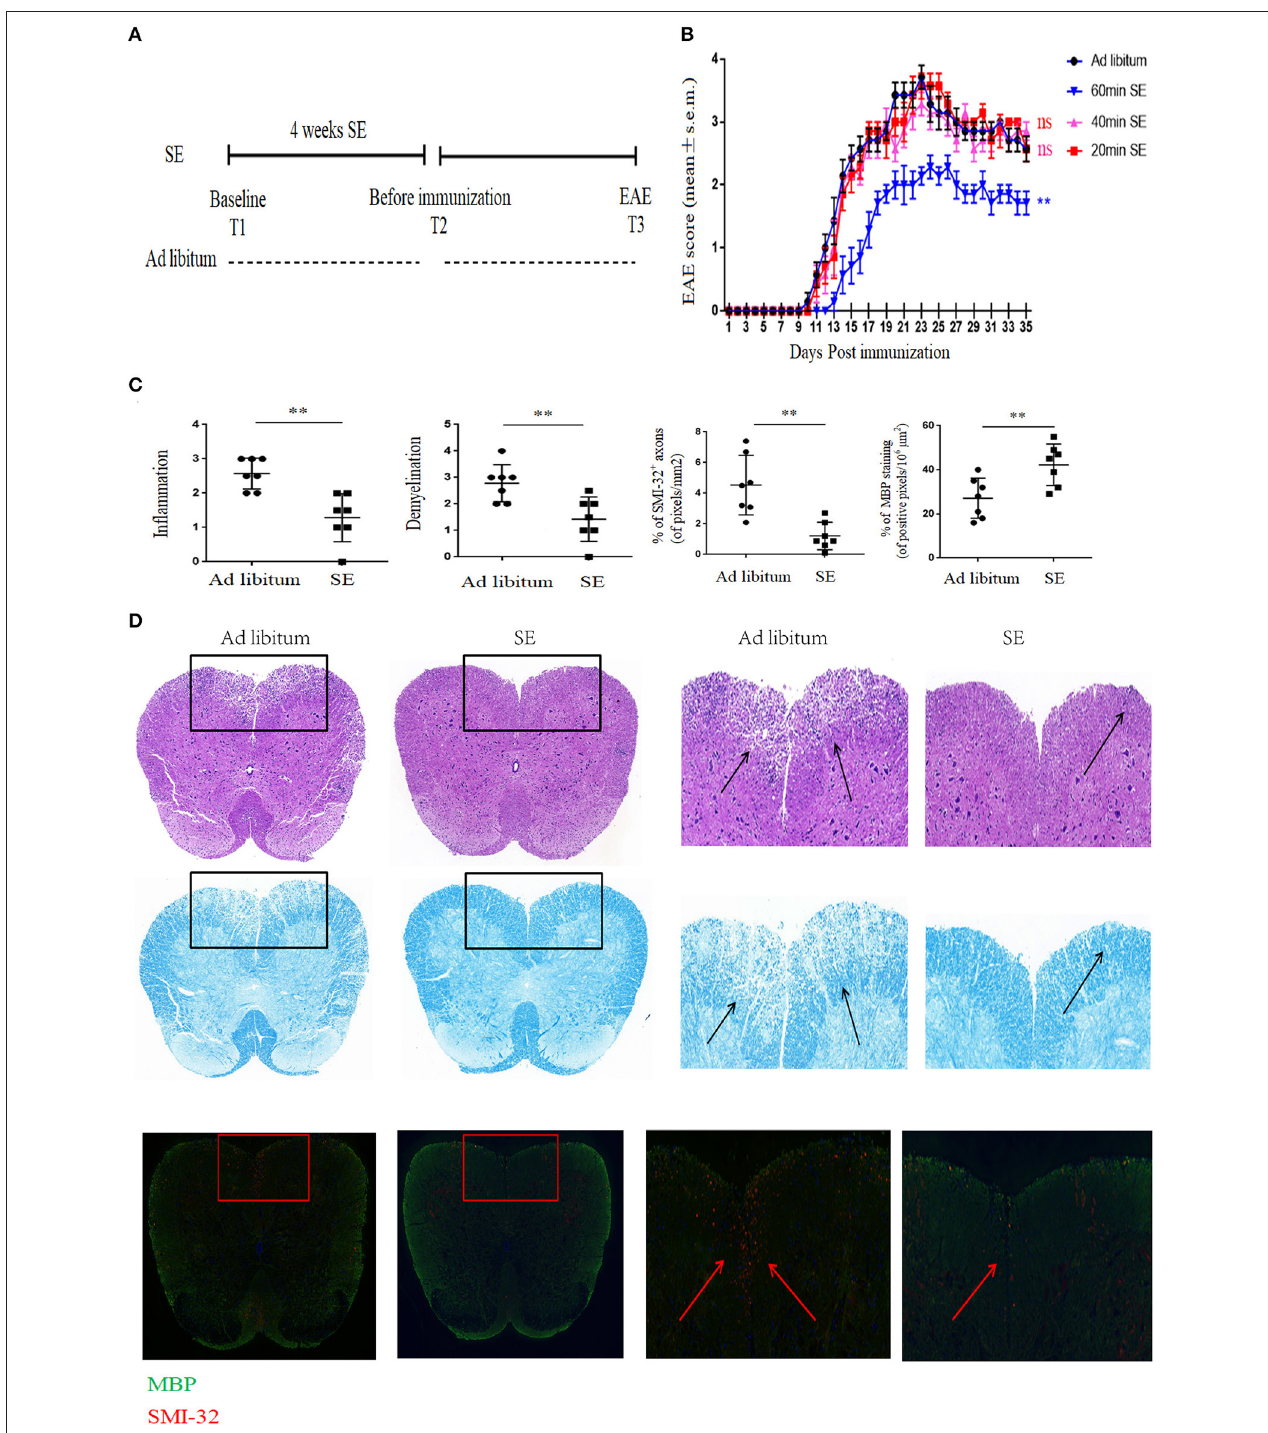
FIGURE 1 | Strength exercise ameliorated clinical severity and neuropathology of experimental autoimmune encephalomyelitis mice. C57BL/6 mice underwent SE or ad libitum (control group) for 4 weeks before immunization. (A) Timeline for the experimental procedures at baseline before starting SE (T1), after 4 weeks SE, but before immunization (T2), clinical EAE (T3). (B) EAE Clinical score of a representative experiment was assessed daily and shown ( n = 7). Three independent EAE experiments were performed with similar results. (C) Histopathology assessment ( n = 7): at 21 days post-immunization, lumbosacral spinal cords were isolated and performed hematoxylin and eosin (H&E) staining, Luxol fast blue staining or immunostaining for SMI-32 + damaged axons (in red) and myelin basic protein (MBP; in green). Scale bars, 200 µ m. (D) Quantification of inflammation, demyelination, MBP staining, and axonal damage (evaluated by SMI-32 + staining) in the lumbosacral spinal cords in the two groups ( n = 7/group) on day 26 post-immunization. Each dot represents a mouse, and the bars are means ± SD. ** p < 0.005.